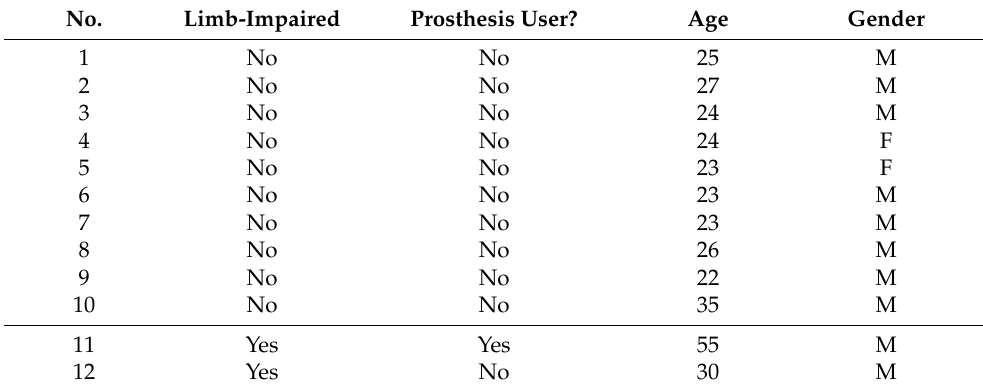
Figure 10. A limb-impaired volunteer testing the UPI with the reduced contraction set of muscles. Table 1. List of volunteers used in the